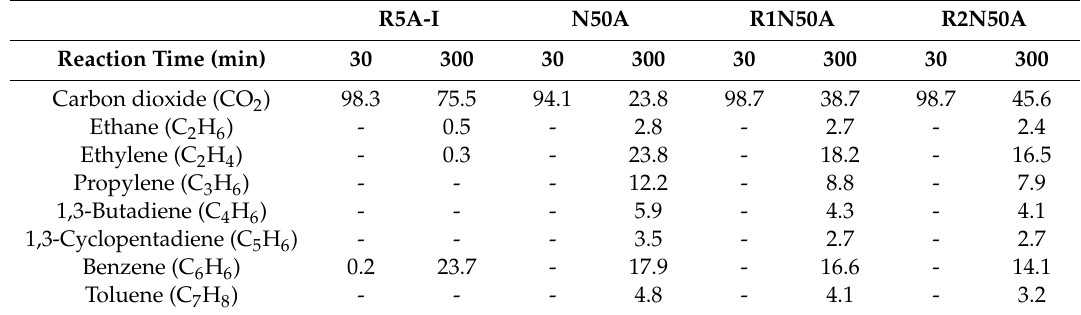
Table 3. Data obtained from GC-MS of R5A-I, N50A, R1N50A, and R2N50A after 30-minute and 300-minute reactions of DHM fuel.